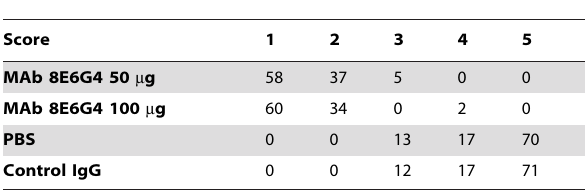
Islets obtained from animals injected with MAb 8E6G4 IgG (50 and 100 m g), control IgG, and PBS were scored as normal islets (score 1), perivascular/ periductal infiltration (score 2), peri-insulitis (score 3), mild insulitis ( , 25% of the islet infiltrated; score 4), and severe insulitis (more than 25% of the islet infiltrated, score 5). The mean score for each group was calculated by dividing the total score by the number of islets scored.